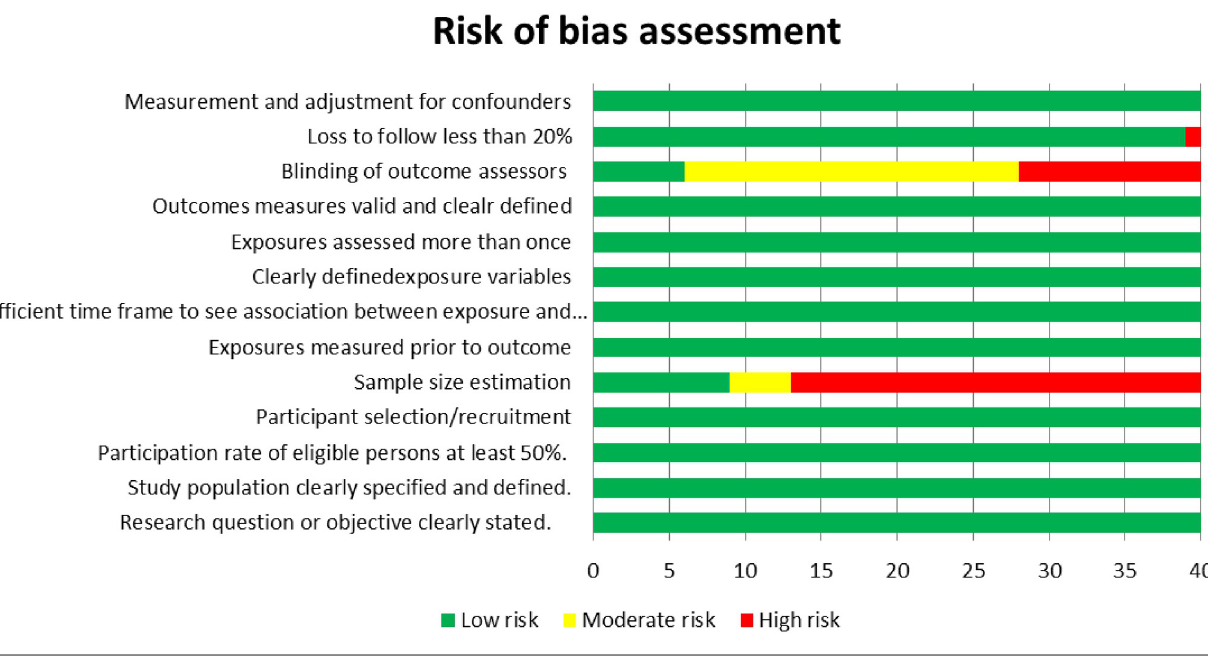
Fig 3. Risk of bias assessment of the prediction